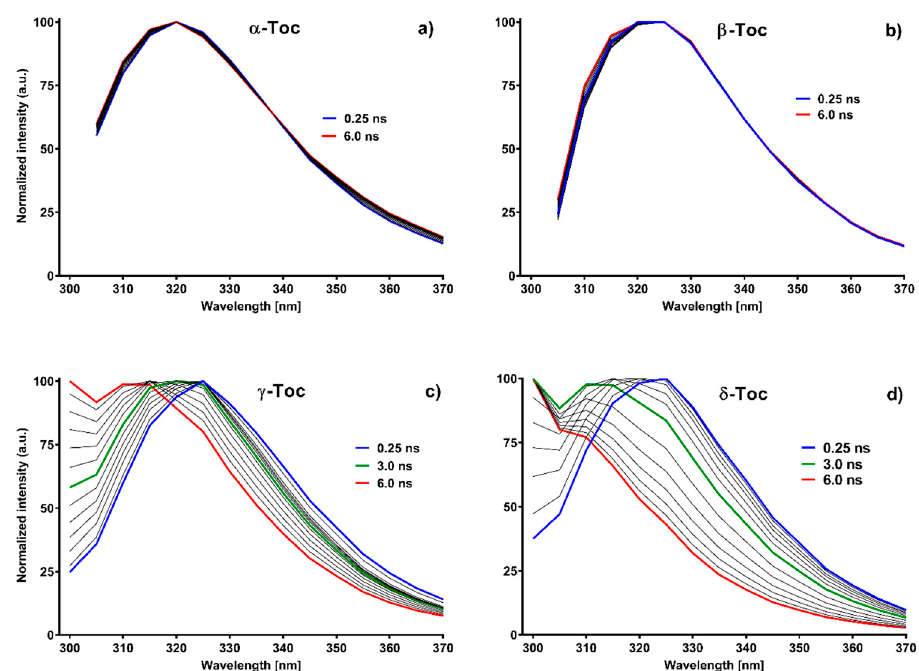
Figure 4. Calculated 2D TRES spectra at the end of irradiation of Tocs. Time step—0.5 ns. Blue lines initial spectra, red lines—final ones. Green spectra are middle spectra. Spectra were calculated using Global method and [39].